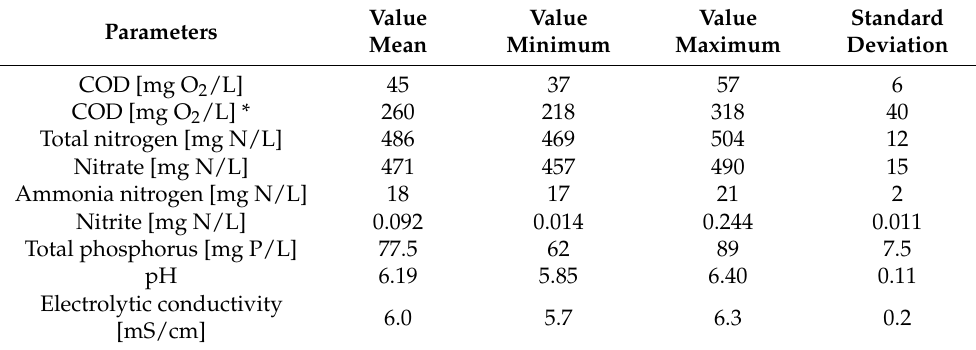
Table 2. The composition of wastewater treated in